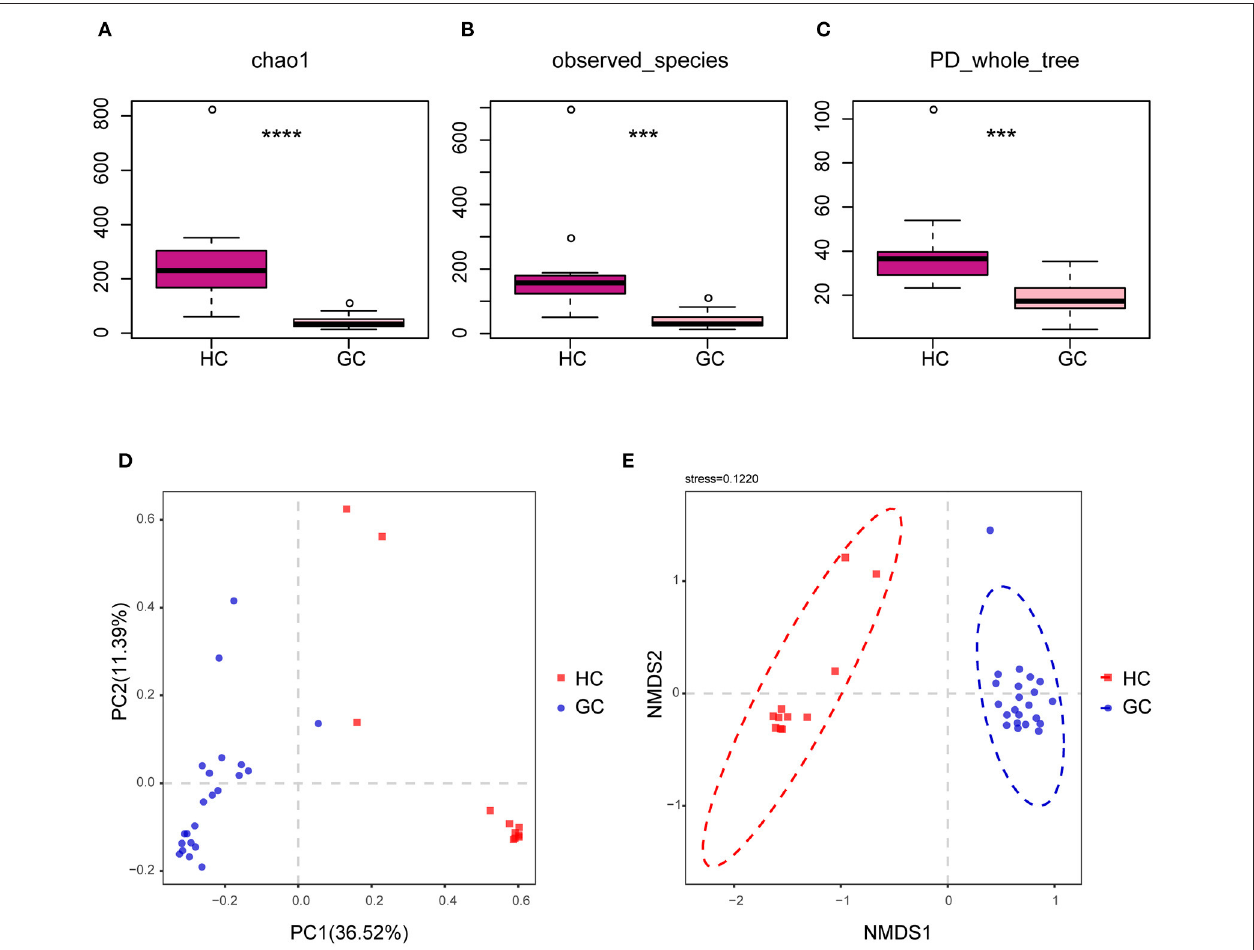
FIGURE 2 | Altered bacterial microbiota biodiversity in GC. (A–C) Alpha diversity. Chao1, observed_species, and PD_whole_tree describe the alpha diversity of the fungi in GC and HC groups (Tukey test, *** p < 0.001; **** p < 0.0001). (D,E) Principal coordinate analysis of Bray–Curtis distance with each sample colored according to different groups. PC1 and PC2 represent the top two principal coordinates that captured most of the diversity. The fraction of diversity captured by the coordinate is given as a percentage. Groups were compared using the PERMANOVA